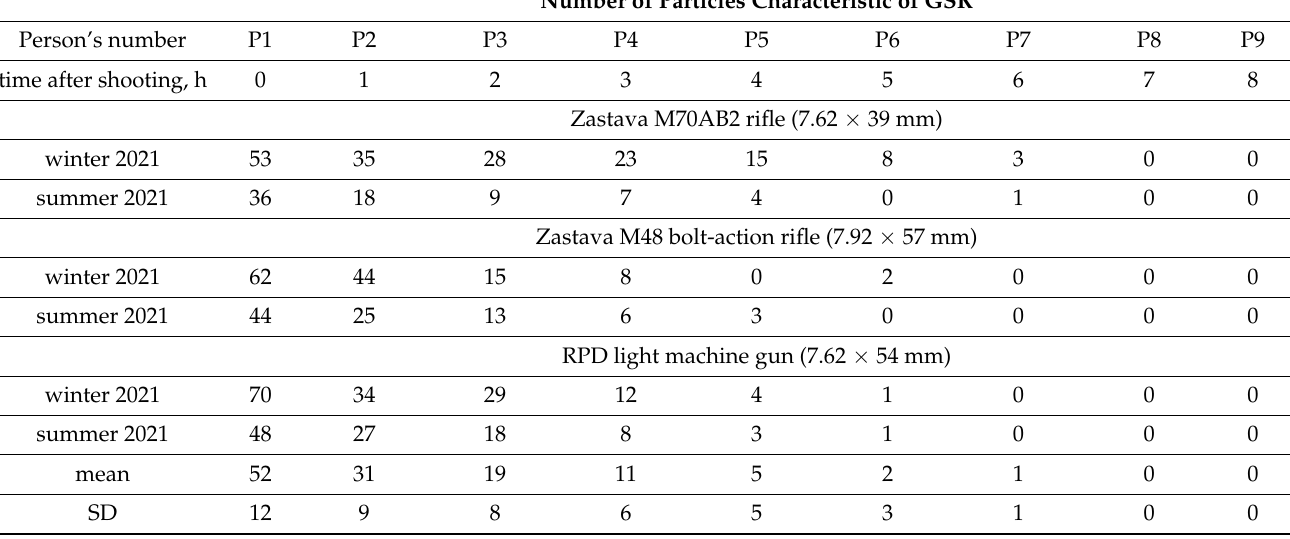
Table 5. Number of particles characteristic of GSR as a function of time after shooting with a high- caliber ammunition. Each person made one shot, followed by normal daily activity without hand washing until GSR